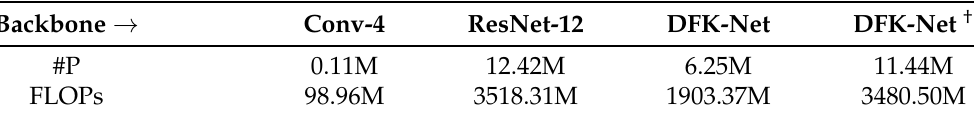
Table 6. Parameter efficiency of different embedding networks. #P stands for the number of parame- ters, and FLOPs denotes the number of multiply-adds, following the definition in [55]. DFK-Net † is a variant of the proposed embedding network.